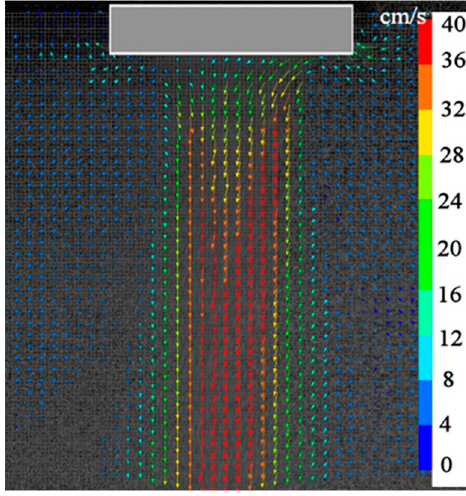
Figure 2. Typical results of PIV measurements.